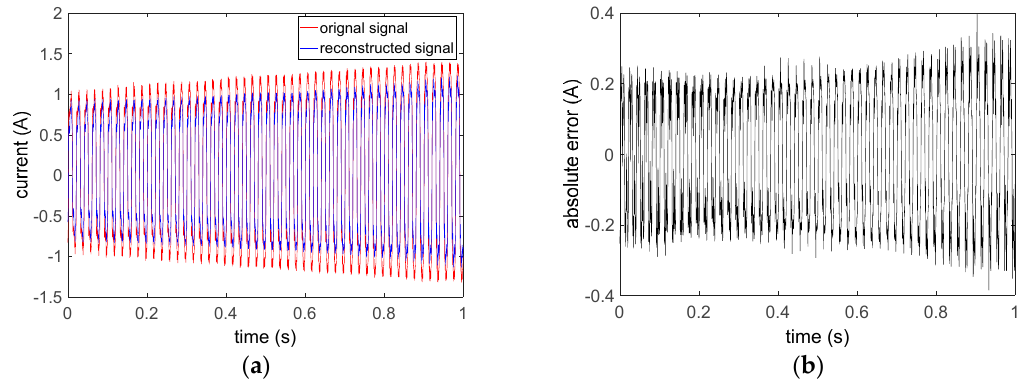
Figure 6. Analysis results of envelope current signal of an electric locomotive when employing the WIFFT and envelope parameter estimation method: ( a ) The comparison of original signal and the reconstructed signal; ( b ) Absolute error of original signal and reconstructed signal.